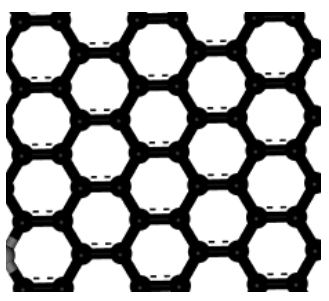
Figure 3. Ideal monolayer graphene structure diagram.